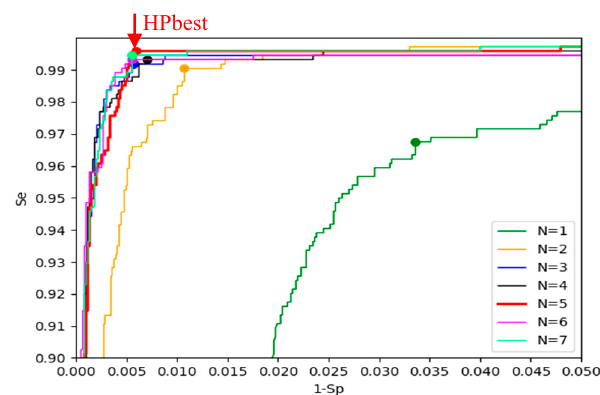
Figure 9. Validation receiver operating characteristic curves (ROC) of HPopt models with different depths (N = 1, 2 … 7). The dot marks correspond to the ROC point with maximal BAC (Se + Sp → max). The red ROC ( N = 5) corresponds to the selected HPbest .